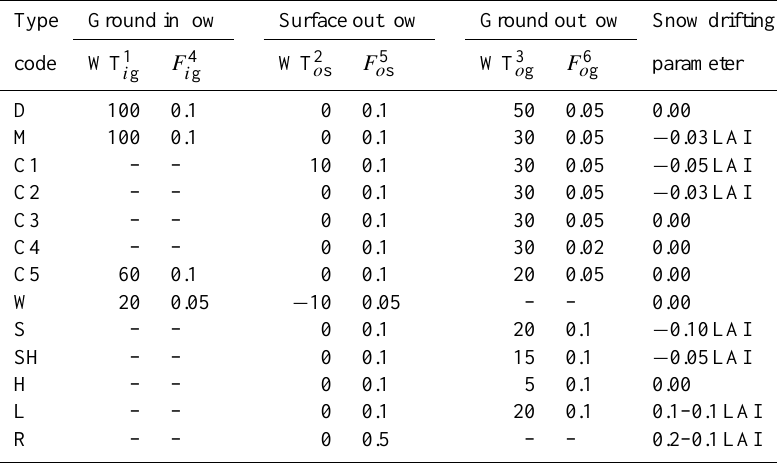
Table 3. Hydrological parameters defined for different land cover types. Type Ground